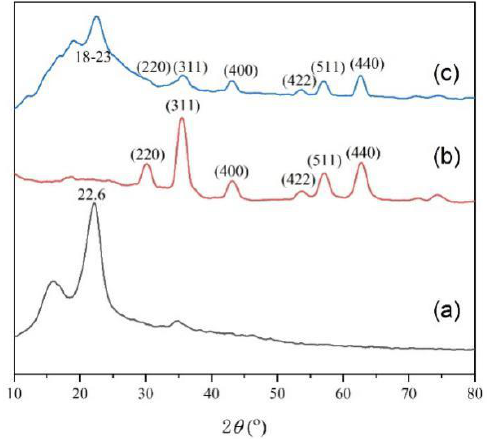
Figure 2. XRD patterns of CF ( a ), Fe 3 O 4 ( b ) and CFS ( c ) materials.